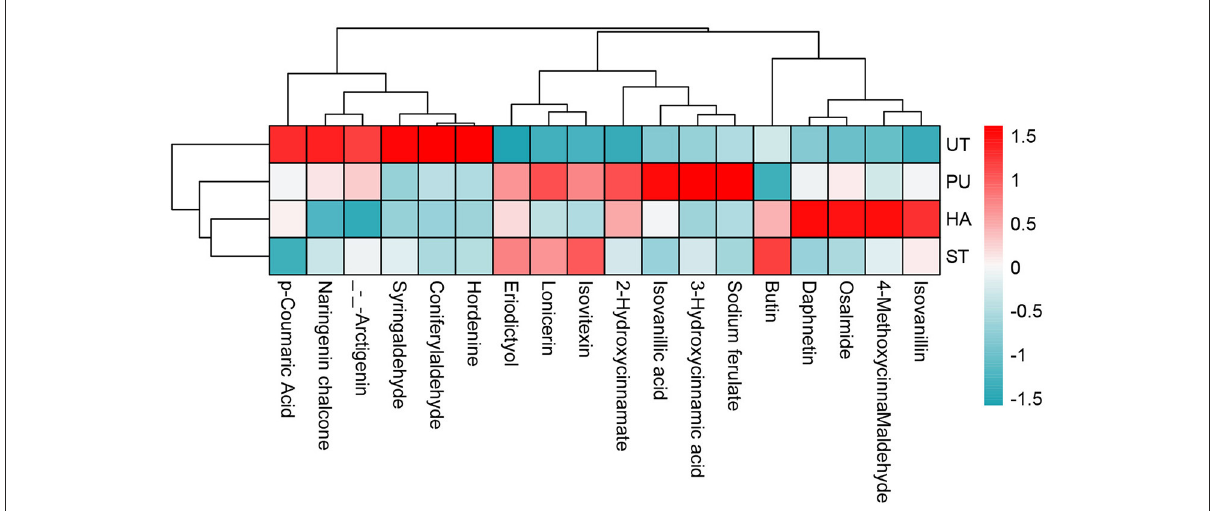
FIGURE11 Heatmap of IBP with VIP > 1 in camellia oil.